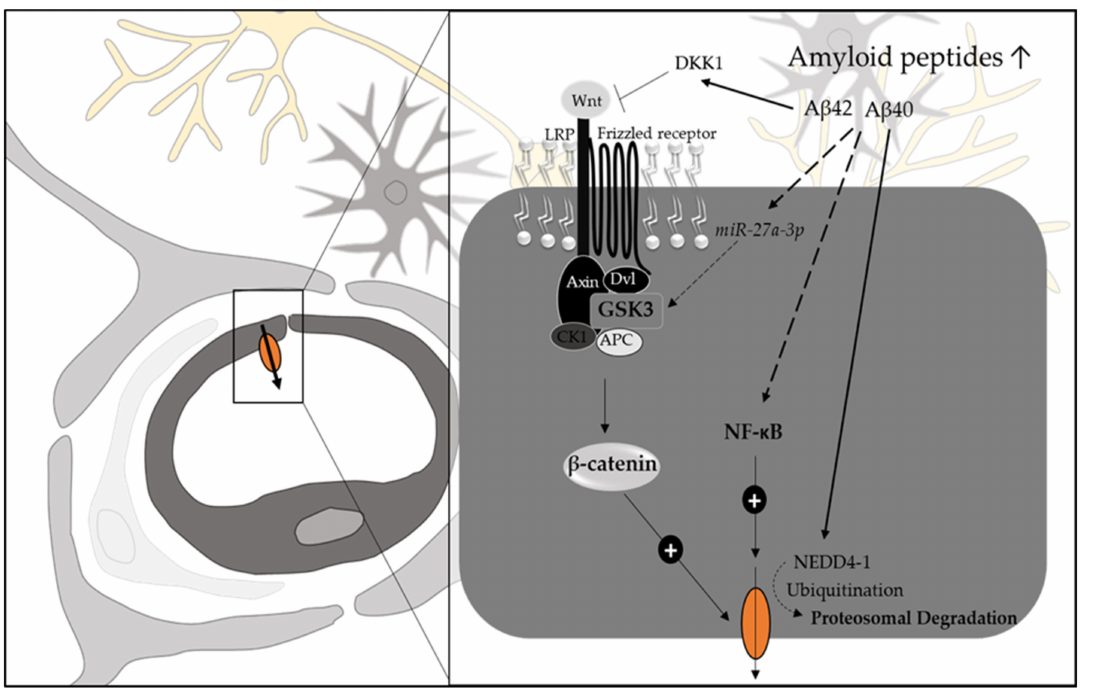
Figure 2. Mechanisms regulating P-gp expression in the blood–brain barrier in Alzheimer’s disease. In AD-affected brain regions, P-gp expression and abundance in the endothelial cells of the blood- brain–barrier is significantly reduced. Various mechanisms have been investigated linking the increased amount of amyloid (A)-peptides A β 40 and A β 42 to a reduction in P-gp involving NF- κ B, and NEDD4-1 mediated ubiquitination and the Wnt/ β -catenin